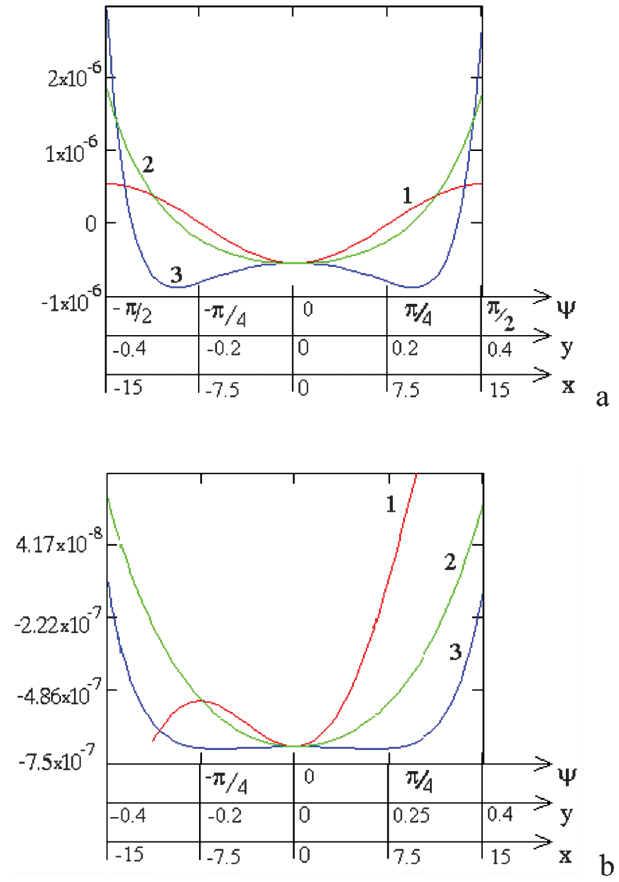
FIG. 5. (Color) The cross sections of effective potential func-